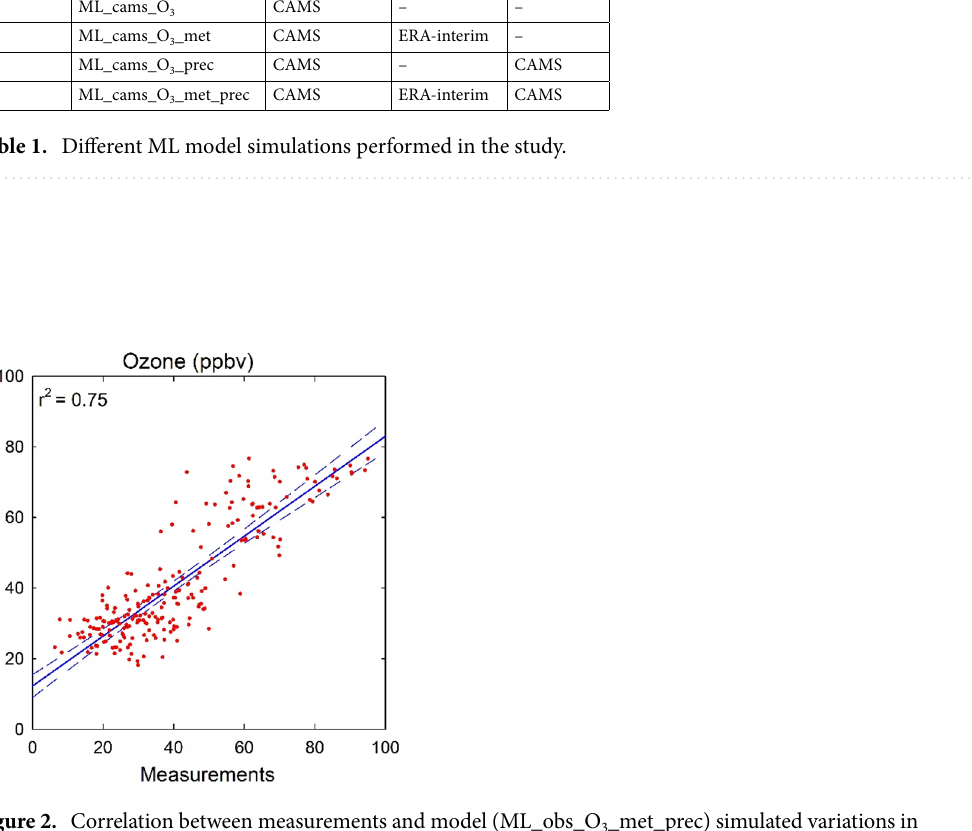
Figure 2. Correlation between measurements and model (ML_obs_O 3 _met_prec) simulated variations in noontime O 3 over Doon valley during April–December 2019. Solid blue line shows the linear regression fit and dashed lines show the 99% confidence